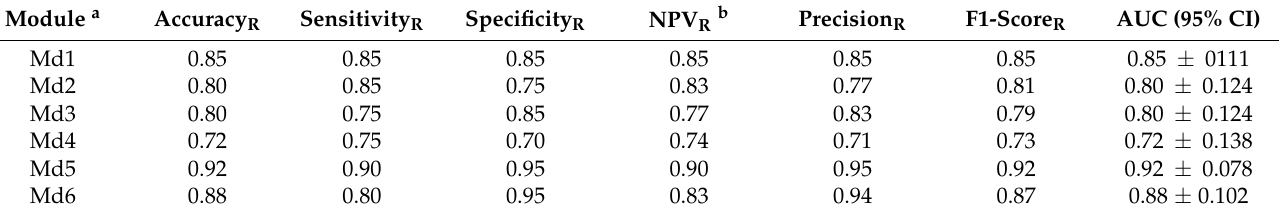
Table 3. Performance of PNI classifier according to the various combinations of segmentation models.